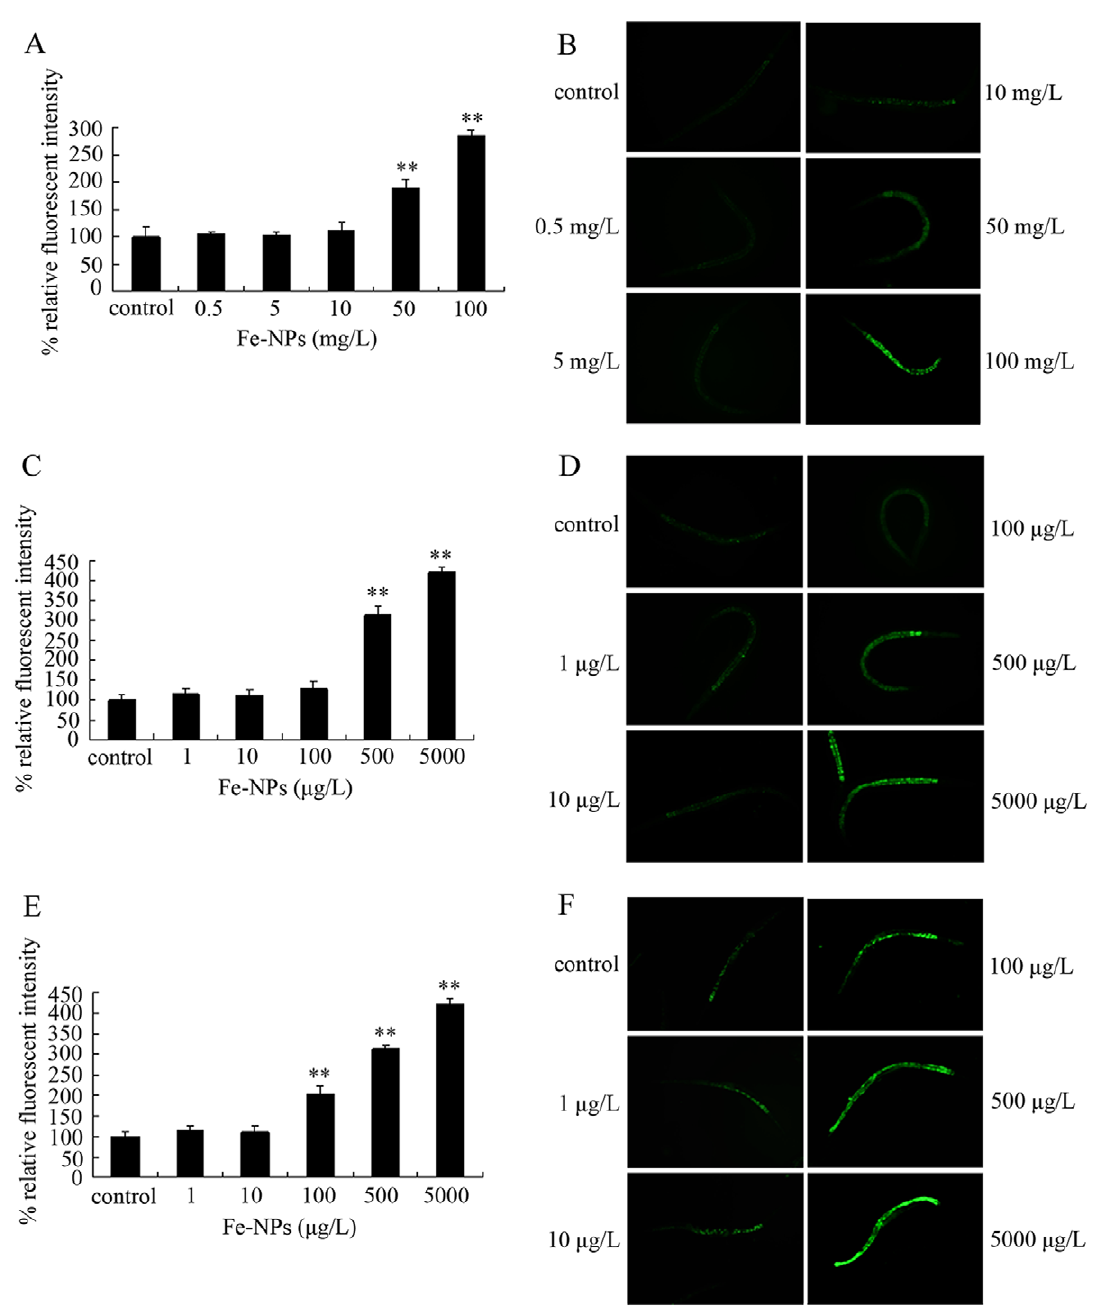
Figure 4. ROS production in nematodes exposed to DMSA coated Fe 2 O 3 -nanoparticles. (A) Comparison of ROS production in nematodes exposed to Fe 2 O 3 -nanoparticles at the L4-larvae stage for 24-hr. (B) Pictures showing the ROS production in nematodes exposed to Fe 2 O 3 - nanoparticles at the L4-larvae stage for 24-hr. (C) Comparison of ROS production in nematodes exposed to Fe 2 O 3 -nanoparticles from L1-larvae to adult. (D) Pictures showing the ROS production in nematodes exposed to Fe 2 O 3 -nanoparticles from L1-larvae to adult. (E) Comparison of ROS production in nematodes exposed to Fe 2 O 3 -nanoparticles from L1-larvae to day-8 adult. (F) Pictures showing the ROS production in nematodes exposed to Fe 2 O 3 -nanoparticles from L1-larvae to day-8 adult. Bars represent mean 6 S.E.M. ** p , 0.01. with ROS production as the independent variable, after DMSA coated Fe 2 O 3 -NPs exposure from L1-larvae to day-8 adult, ROS production was significantly correlated with lethality (R 2 =0.920, p , 0.01), growth (R 2 =0.883, p , 0.01), body bend (R 2 = 0.947, p , 0.01), head thrash (R 2 =0.920, p , 0.01), pumping rate toxicity evaluation assay systems.